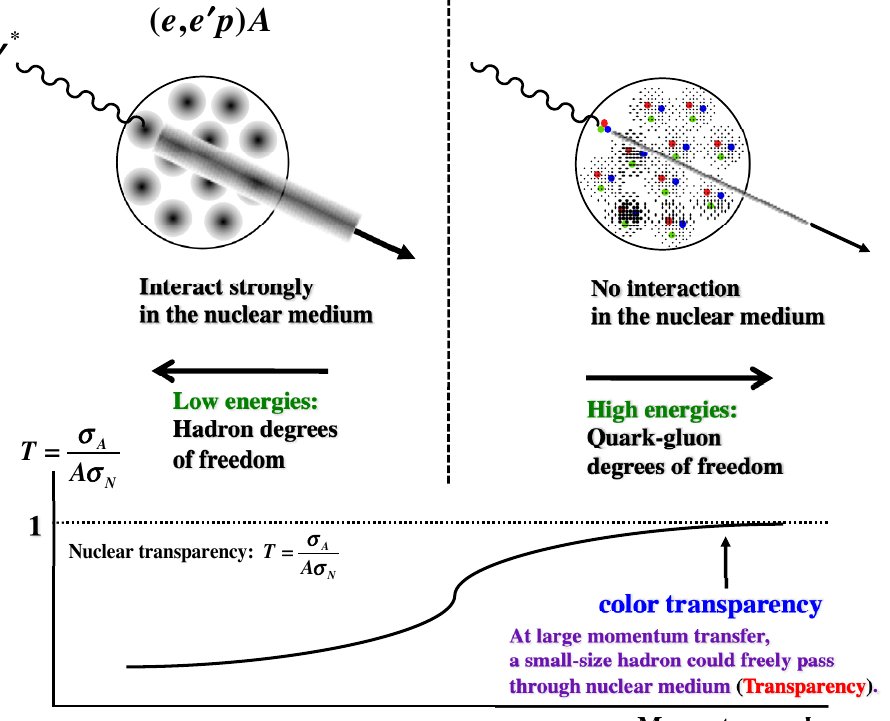
Figure 3. Color transparency in high-energy electron scattering ( e , e (cid:48) p ) A